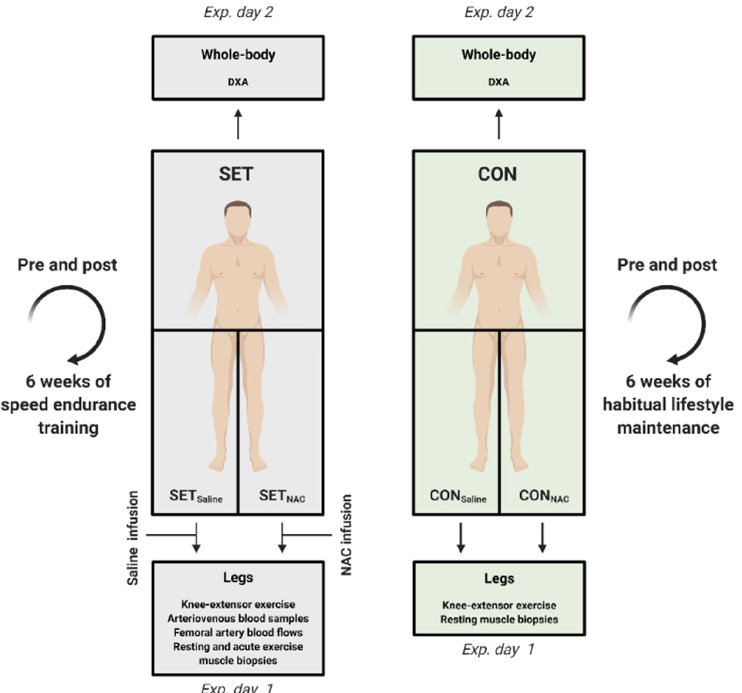
Figure 1. Schematic overview of the experimental protocol. Exp. day, experimental day; DXA, dual-energy X-ray absorptiometry; NAC, N -acetylcysteine; SET, speed endurance training group; SET Saline , right leg in SET (i.e., leg receiving saline infusion before and after the SET intervention); SET NAC, left leg in SET (i.e., leg receiving NAC infusion before and after the SET intervention); CON, control group; CON Saline , right leg in CON; CON NAC , left leg in